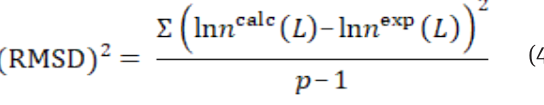
SDG MSMPR models were preliminary tested. Their G ( L ) population density distributions n ( L ) are presented in Table 2. Eqs. (4), (6), (8), (10) and (12) were then fitted (using nonlinear regression analysis) to experimentally determined population density distributions of struvite crystals (7 experimental n ( L ) distributions). For each experimental data set and for each model (Table 2) the parameters of n ( L ) distributions were calculated, making determination of variance (Eq. (14) possible: